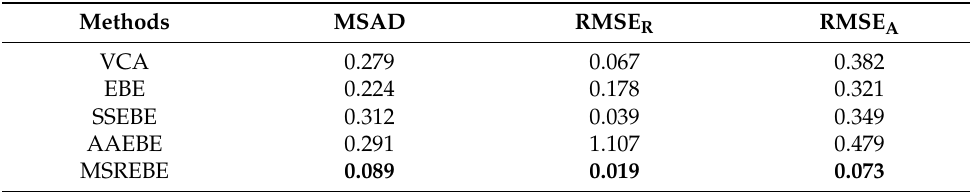
Table 2. Experimental results of wetland dataset.